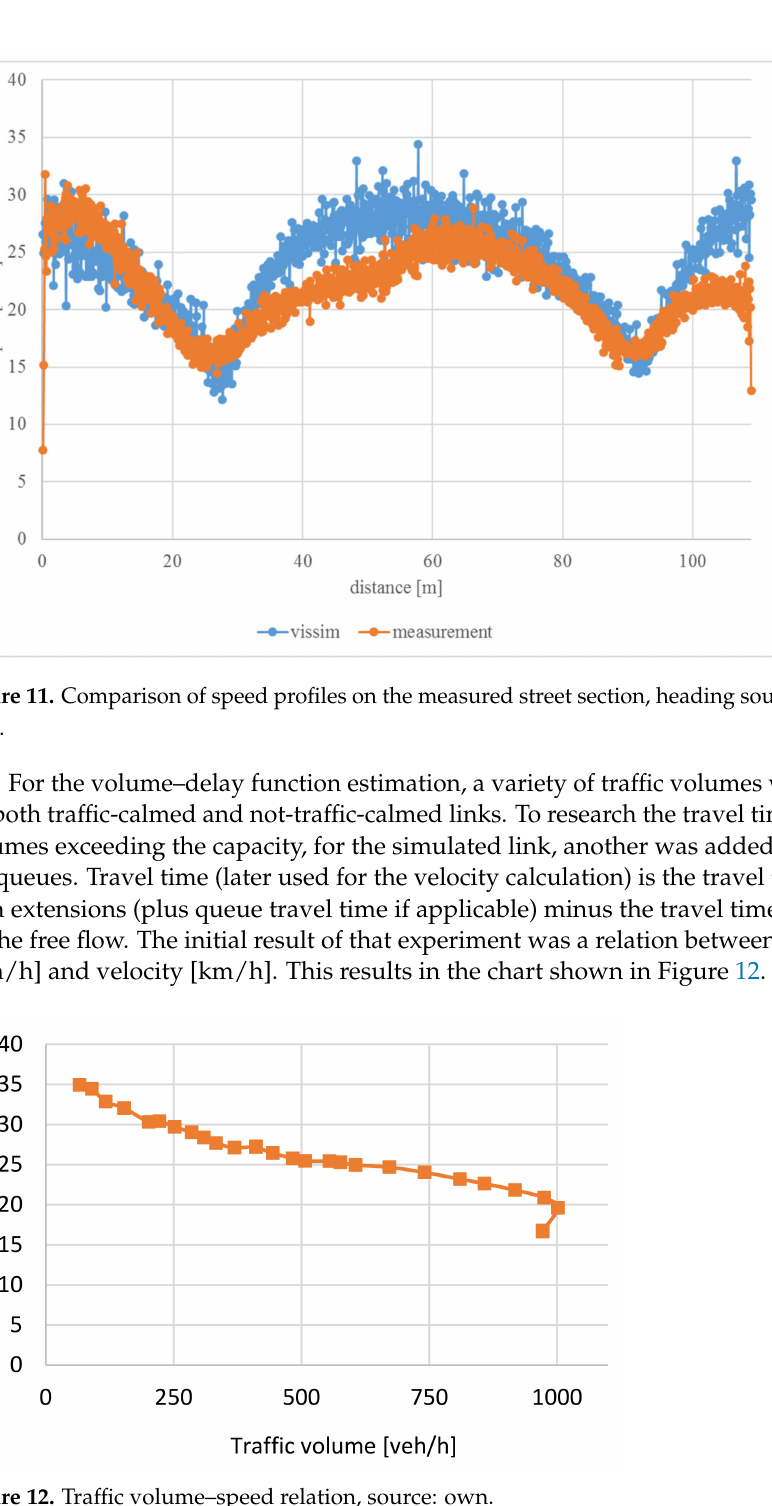
Figure 12. Traffic volume–speed relation, source: